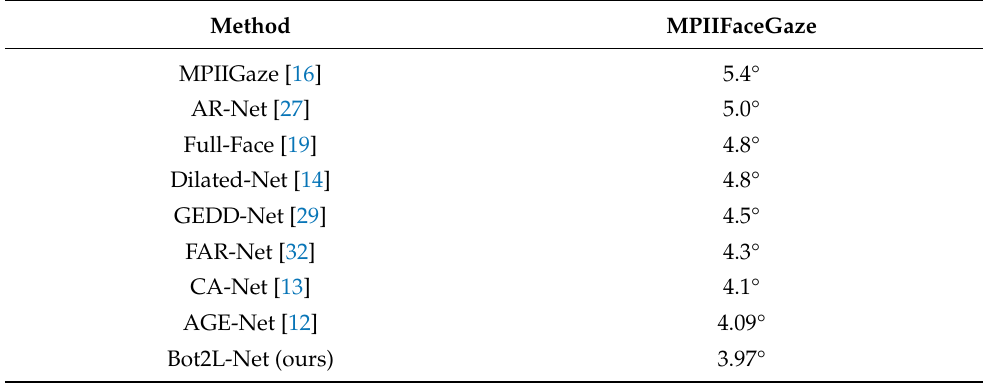
Table 2. Comparison of mean angular error between our proposed model and state-of-the-art methods on the Gaze360 testing